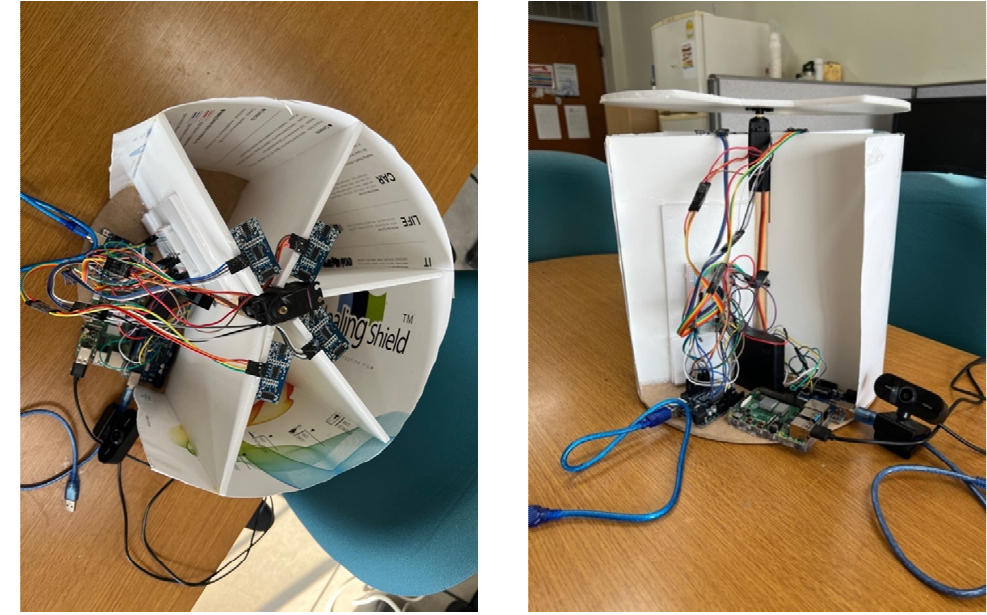
Figure 9. Final hardware assembly.